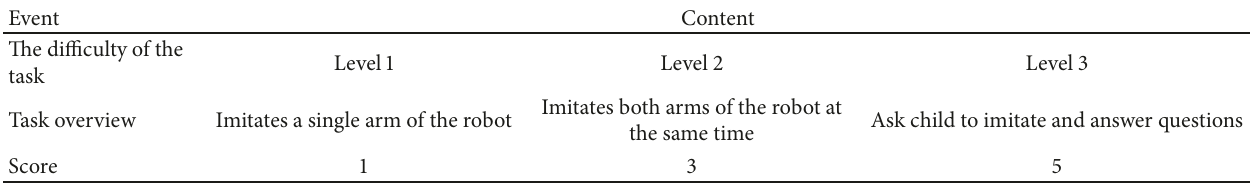
Table 1: The description of the